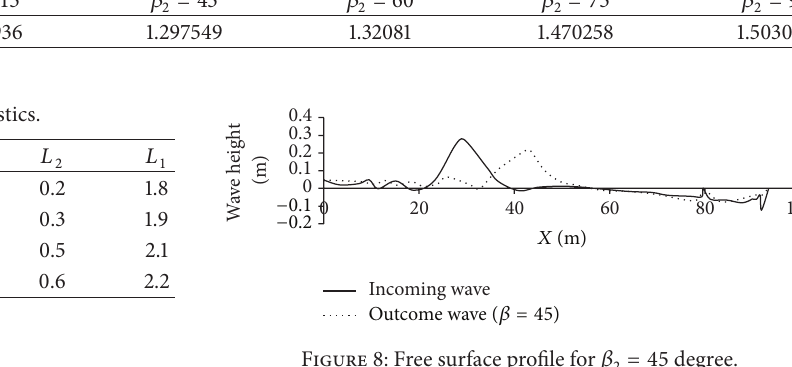
Figure 8: Free surface profile for 𝛽 2 = 45 degree.